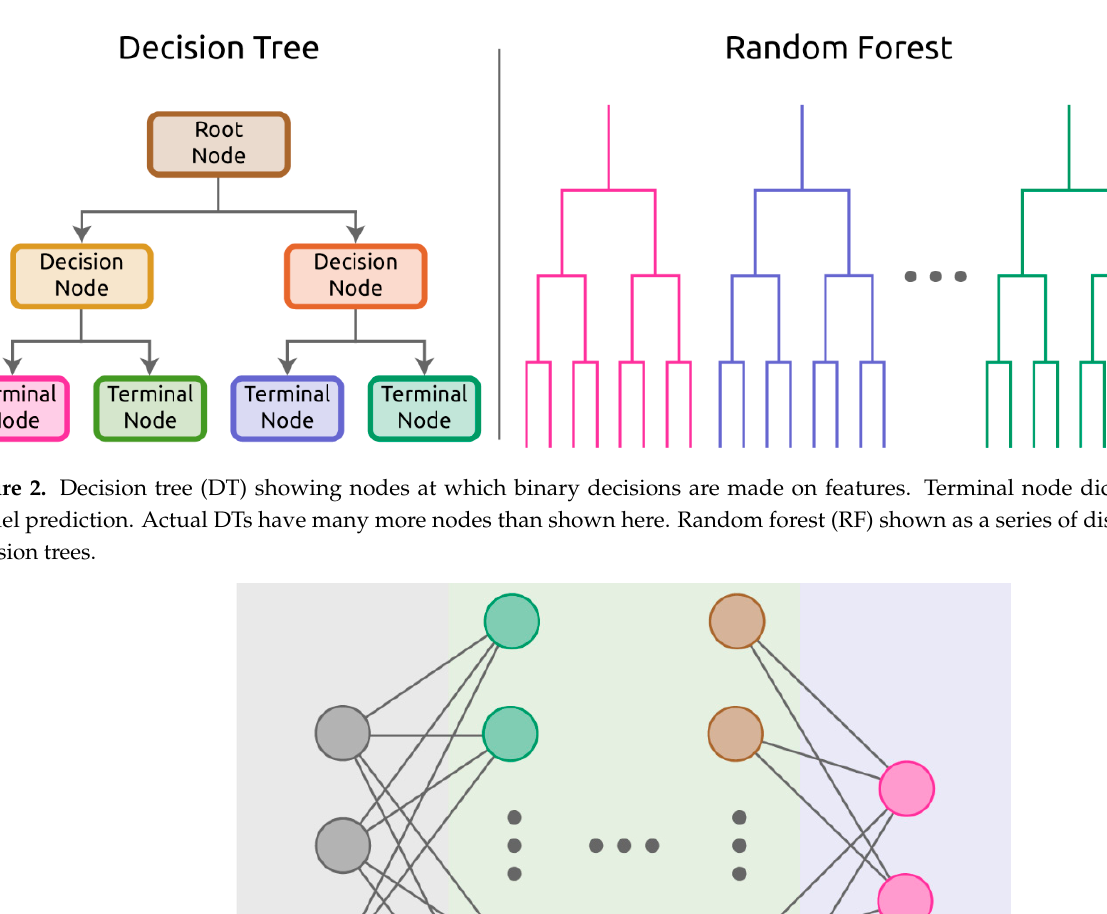
Figure 2. Decision tree (DT) showing nodes at which binary decisions are made on features. Terminal node dictates model prediction. Actual DTs have many more nodes than shown here. Random forest (RF) shown as a series of distinct decision trees.